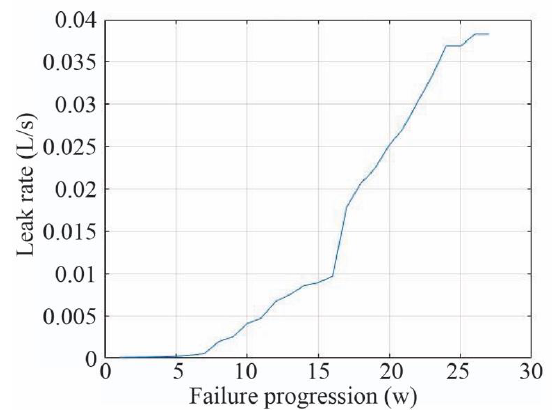
Figure 12. Evolution of the greenhouse ‘Tank leak’ failure mode (F_1).